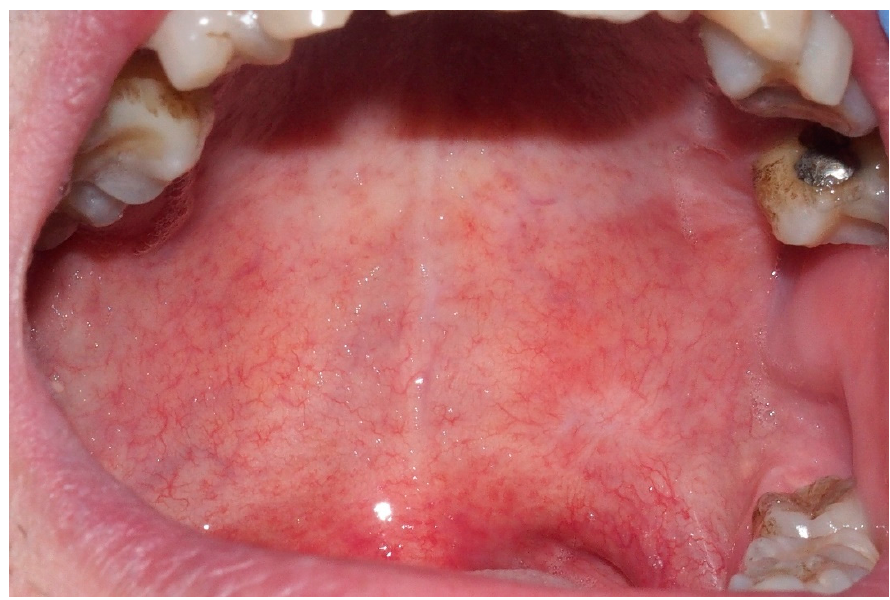
Figure 5. Appearance of the soft palate at one year after the removal of the lesion. At the time of writing, after two years of follow up, the patient has shown no signs of new disease, recurrence, or conversion to multiple myeloma. The patient gave consent for the communication of her case.